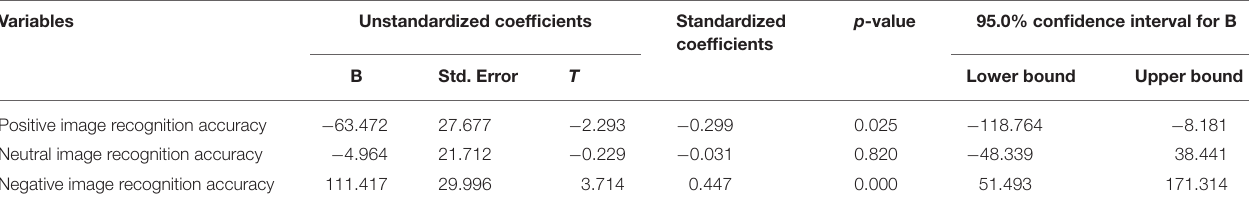
TABLE 5 | Predictors generated by multiple linear Regression with CSI as dependent variables ( n = 68).